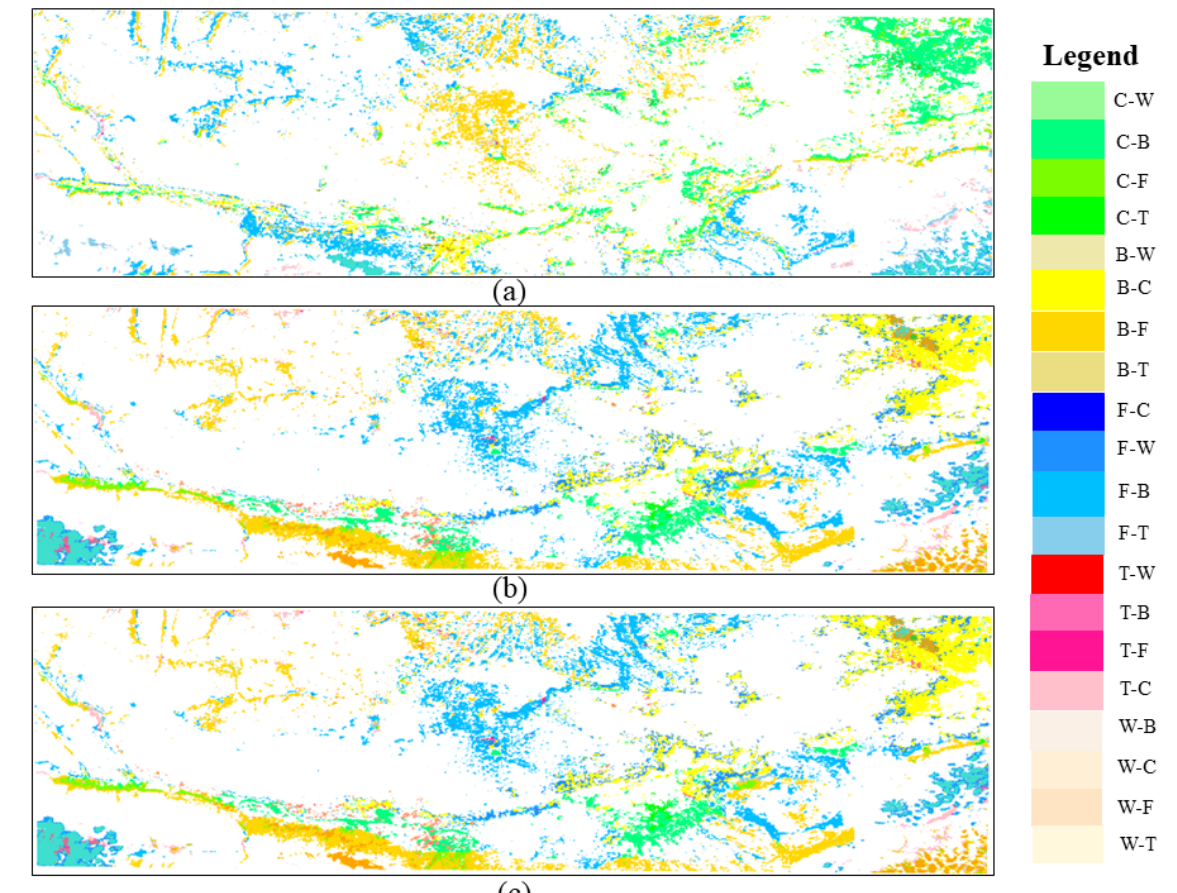
Figure 11. Map of land use changes in the study area from 2011 to 2014. ( a ) A map of land use changes from 2011 to 2012. ( b ) A map of land use changes from 2012 to 2013. ( c ) A map of land use changes from 2013 to